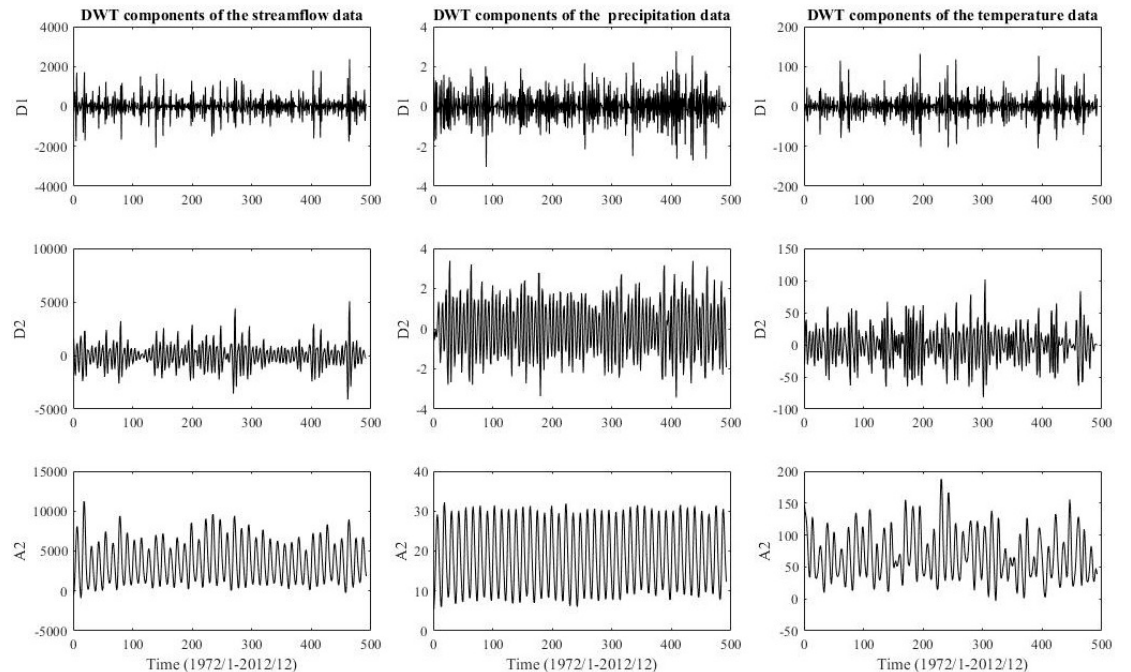
Figure 6. Zone Three: streamflow, precipitation, and temperature data are decomposed by DWT.